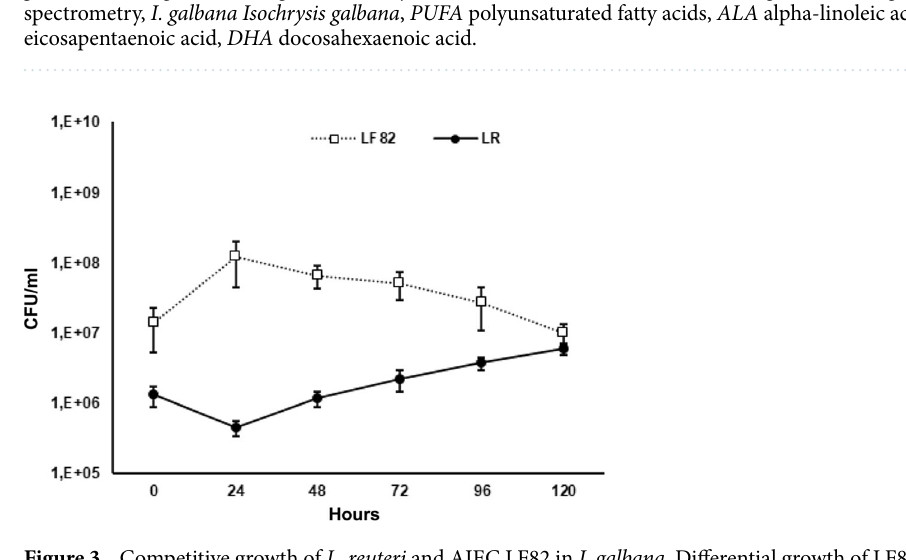
Figure 2. Microalga omega3 profile before and after L. reuteri fermentation. Lipidomic analysis by GC–MS of I. galbana showing PUFA-omega3 availability. L. reuteri Lactobacillus reuteri , GC–MS gas-chromatography mass-